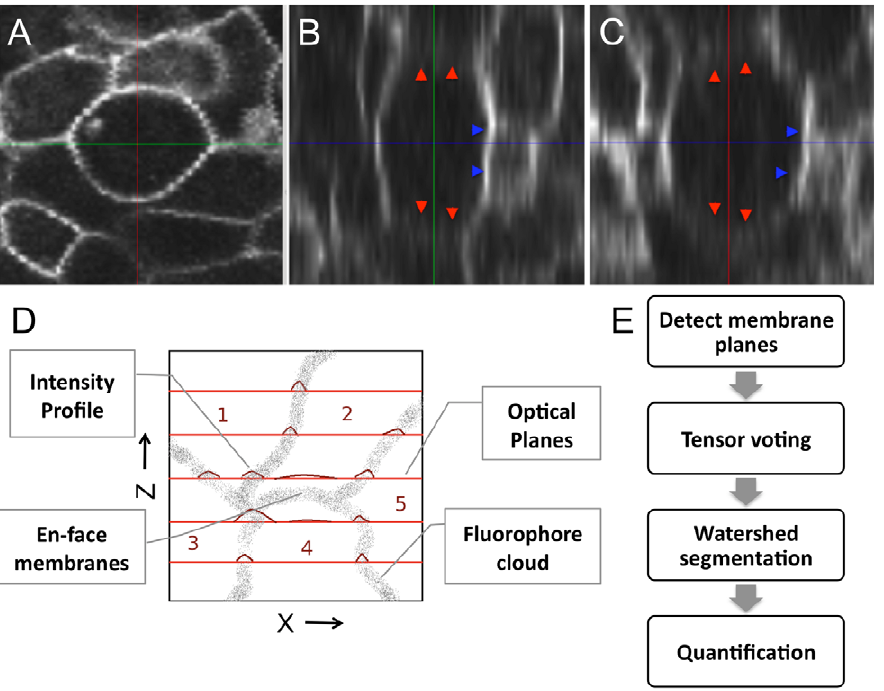
Figure 1. Reconstructing the membrane signal by eliminating intensity inhomogeneities. A single cell membrane is shown across (A) XY , (B) XZ , and (C) YZ sections. The XY plane shows a consistently bold and uniform membrane signal while the XZ and YZ views show a non-uniform membrane signal. Membrane planes en-face to the XY optical planes (marked by red arrows) are very weak and markedly diffuse in intensity. Membranes orthogonal to the XY imaging plane are sharper (blue arrows). (D) A qualitative model describing the formation of a membrane image under a fluorescent microscope. Flourophores tagged to membranes are shown as a point cloud (input). The XY focal planes are shown in red and the obtained intensity profiles on the plane are shown as plots. Cell membranes imaged oblique and en face such as the interface between cells 2 { 4 are poorly visible in comparison to those orthogonal to the focal planes. (E) Three stages in the reconstruction process: (i) Detect membrane planes by mining for planar fluorophore distributions. This allows even weak membranes ( en-face or oblique) to be extracted and accounts for intensity inhomogeneity. (ii) Voting to fill structural gaps or holes in the membrane signal that may not be contiguous. (iii) Region segmentation using the watershed algorithm to extract three-dimensional cell meshes for quantification.